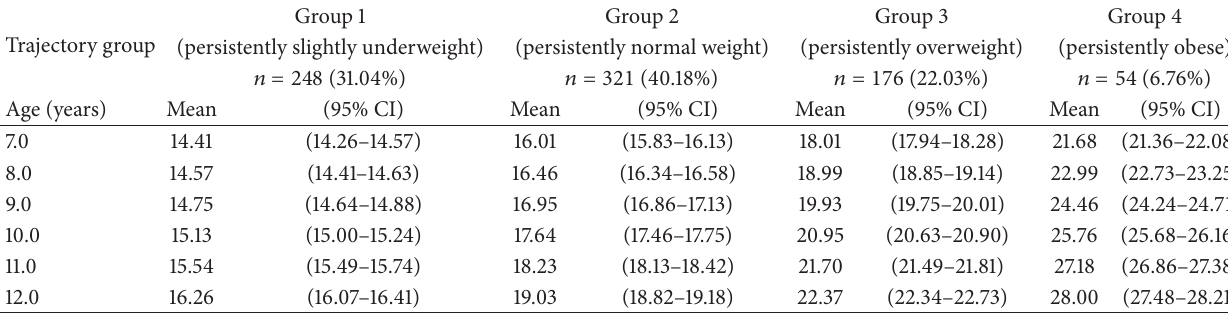
Table 3: Mean BMI by BMI trajectory group and age in